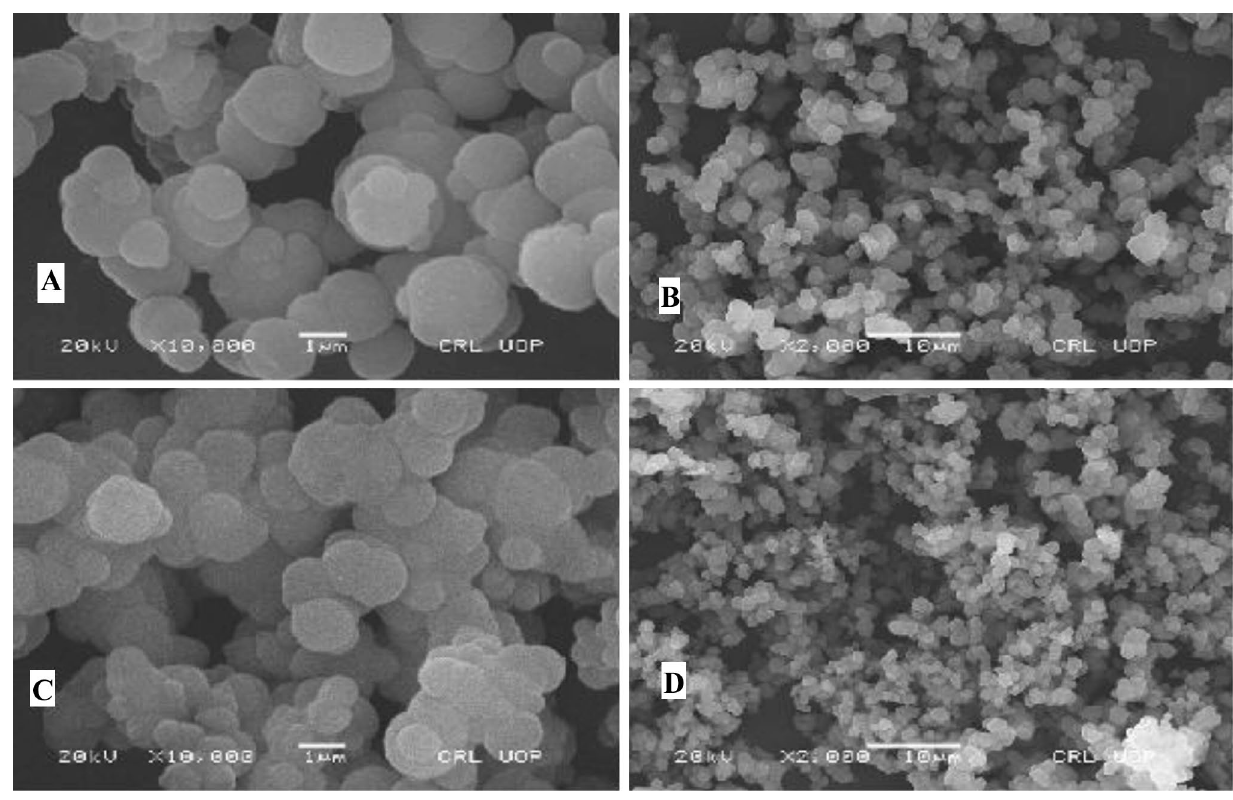
Fig. 7 Scanning electron micrographs of Fe(III)-IIP ( a , b ) and non-IIP ( c , d ) at 10,000 and 2000 magnification Table 3 Thermodynamic parameters studied for ion imprinting